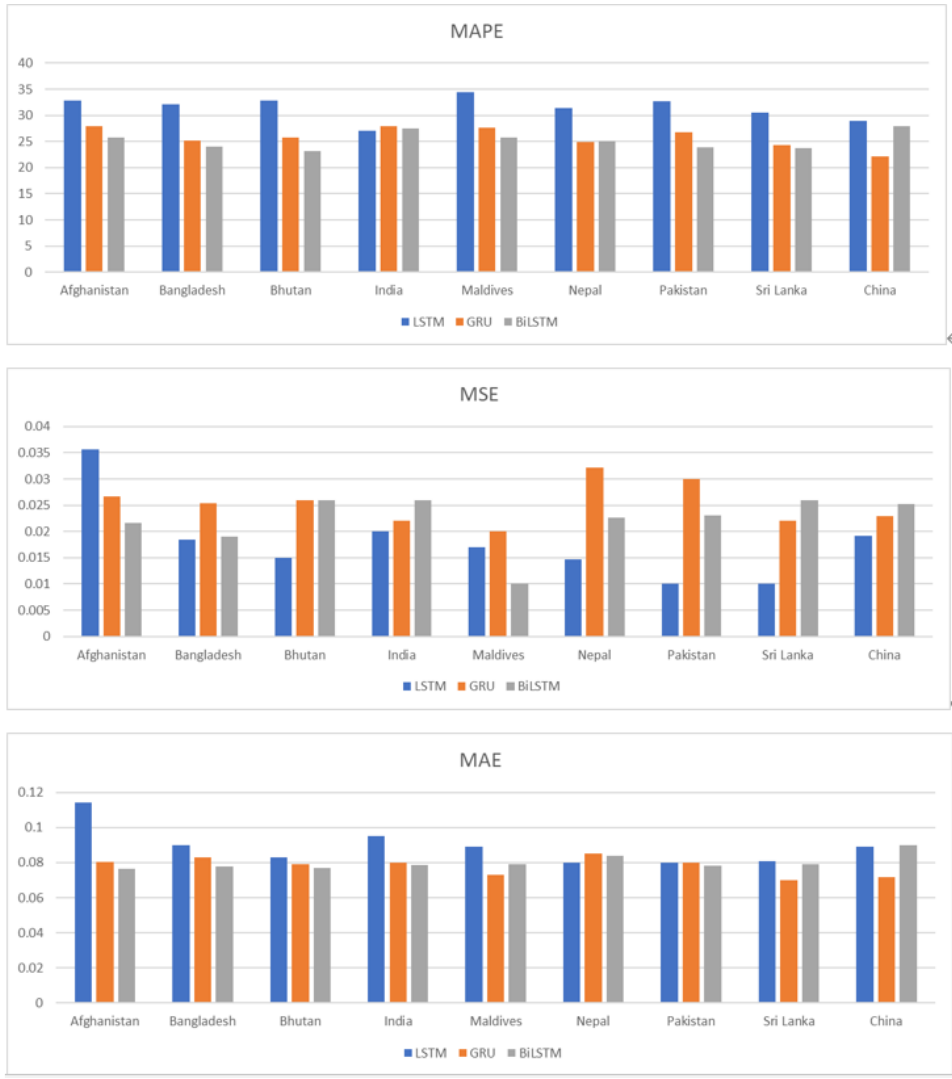
Figure 5. The MAE, MSE, and MAPE of South Asian Countries and China.